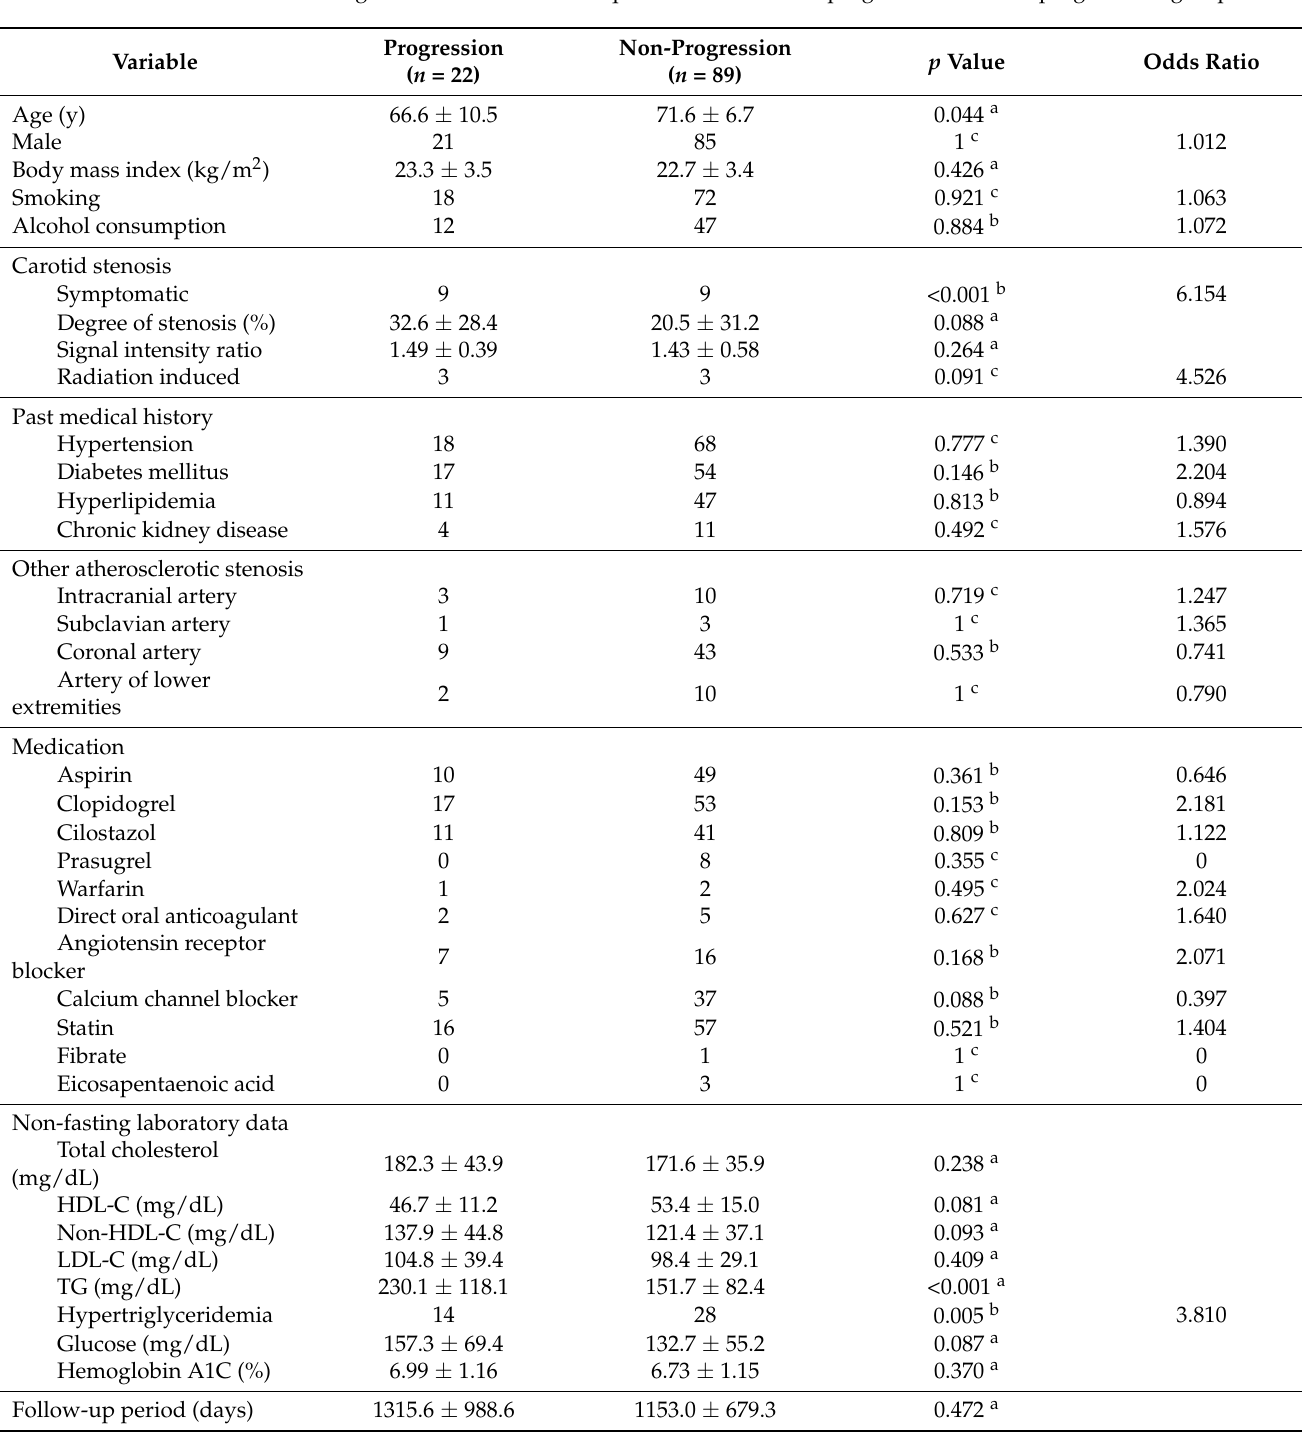
Table 1. Comparisons of baseline clinical characteristics and non-fasting laboratory data at the initial diagnosis between the subsequent carotid stenosis progression and non-progressions